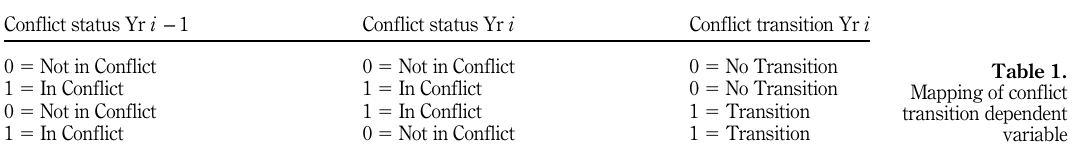
Table 1. Mapping of conflict transition dependent